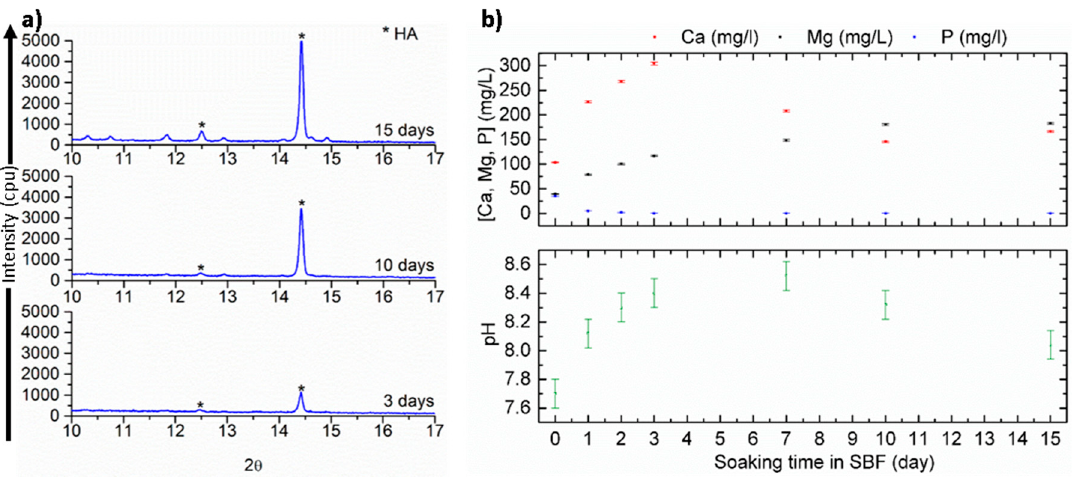
Figure 4. ( a ) XRD patterns of SiCaMgOC-1100 after soaking in SBF for 3, 10, and 15 days; ( b ) evolution of the Ca, Mg, and P contents in SBF ( above ) and pH ( below ) as a function of soaking time during the exposure of SiCaMgOC-1100 powder samples at 37 °C.